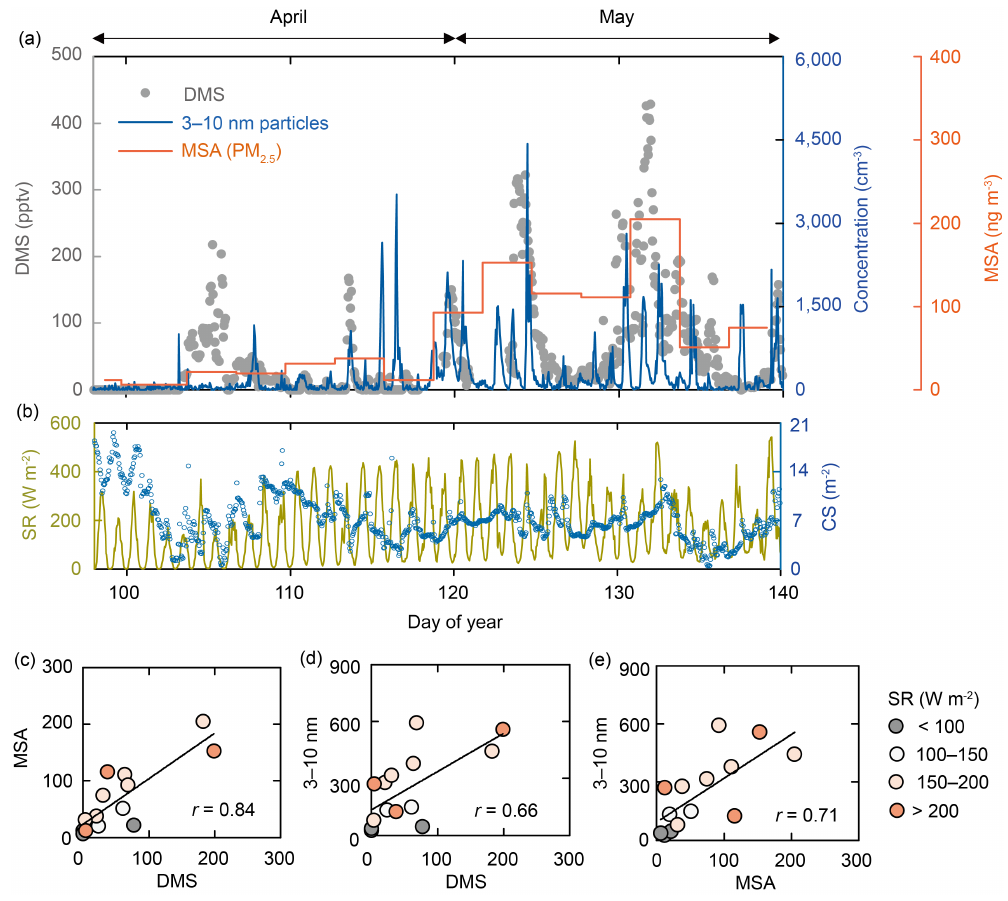
Figure 1. (a) The mixing ratios of atmospheric DMS measured at the Zeppelin observatory (gray circles), the concentration of nucleation- mode particles (3–10nm in diameter) measured at the Gruvebadet observatory (1km distant from Zeppelin station) (blue line) and the concentration of MSA collected at the observatory (red line) during April and May 2015. (b) The solar irradiance (SR) measured in Ny- Ålesund (yellow line), and the condensation sink (CS) calculated by Kerminen et al. (2004) (blue circles). (c) The relationship between the atmospheric DMS mixing ratio, averaged for 3 days, and the corresponding MSA concentration. (d) The relationship between the atmospheric DMS mixing ratio, averaged for 3 days, and the corresponding concentration of nucleation-mode particles. (e) The relationship between the MSA concentration and the corresponding concentration of nucleation-mode particles. The colors of the circles in (c–e) indicate the intensity of solar irradiance (SR; integrated over a wavelength range of